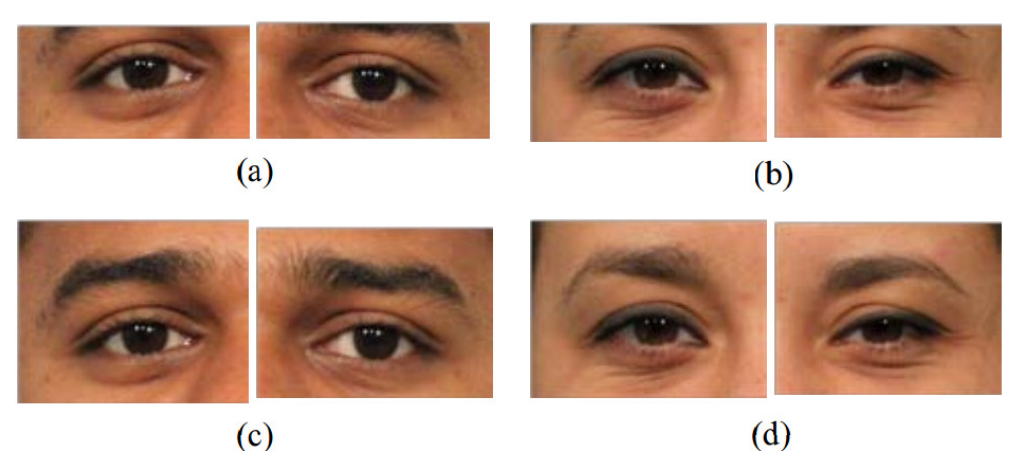
Figure 8. Example periocular images from two different subjects [30]: ( a , b ) without eyebrows; and ( c , d ) with